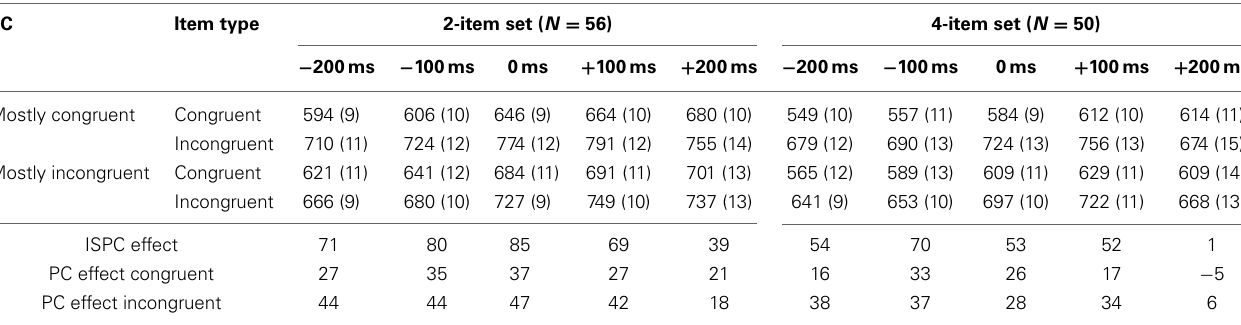
Table 2 | Mean correct RTs (ms) for the conditions of Experiment 1.